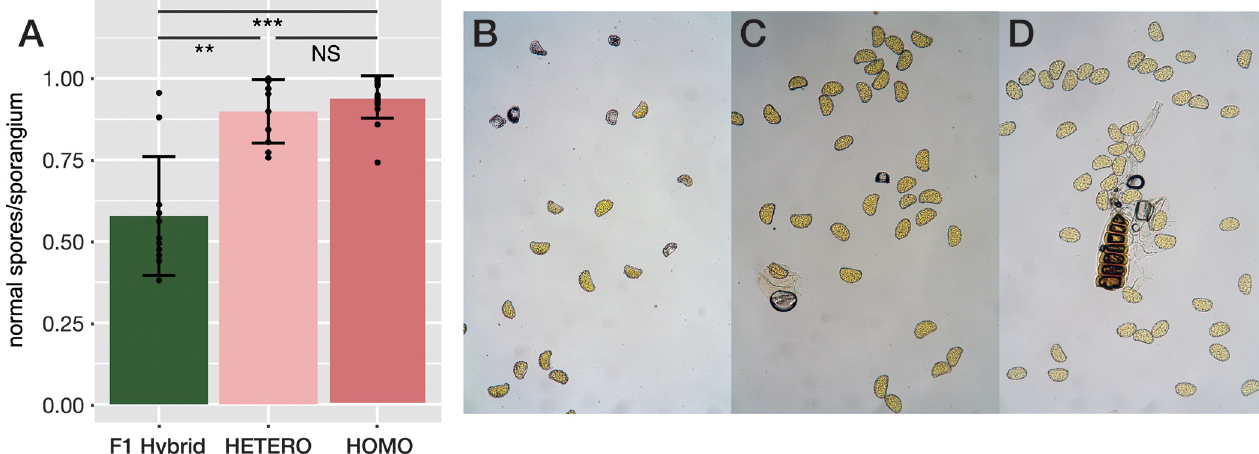
Fig 6. The level of fertility among three categories, F 1 hybrids, heterozygous individuals within each type and homozygous individuals within each type. The proportion of normal spores in F 1 hybrids between types (F 1 hybrid in the figure, left), heterozygous individuals within each type (HETERO in the figure, centre), and homozygous individuals within each type (HOMO in the figure, right) (A), and photographs of spore morphologies in each category: (B) an F 1 hybrid (sample ID 26–4) between types, (C) an heterozygous individual (sample ID 15–2) of the East-type, and (D) an homozygous individual (sample ID 15– 1) of the East-type. In the graph (A), each point in the bar indicates an individual data point; error bars represent SE ( ± ). Asterisks represent differences at confidence levels of �� p < 0.005 and ��� p < 0.001.